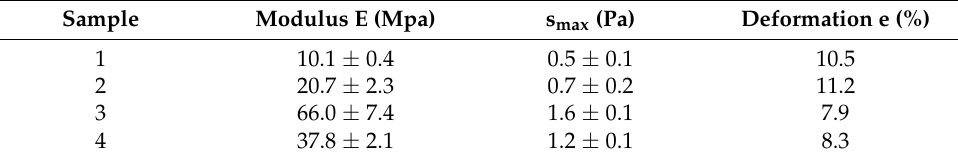
Table 5. Effect of rapeseed cake transformation processing on tensile